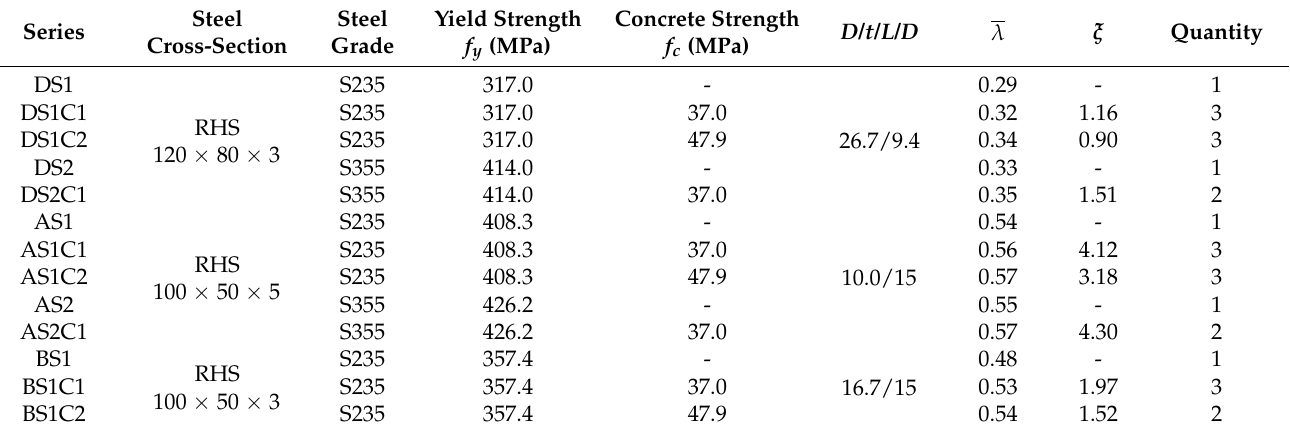
Table 1. Material and geometric properties of the investigated columns—experimental